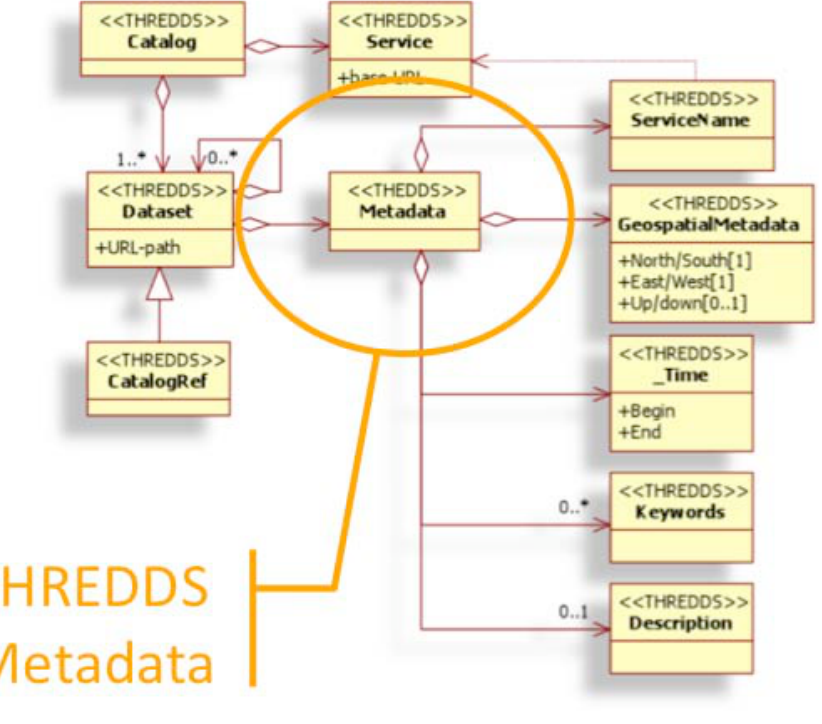
Fig. 6. THREDDS data